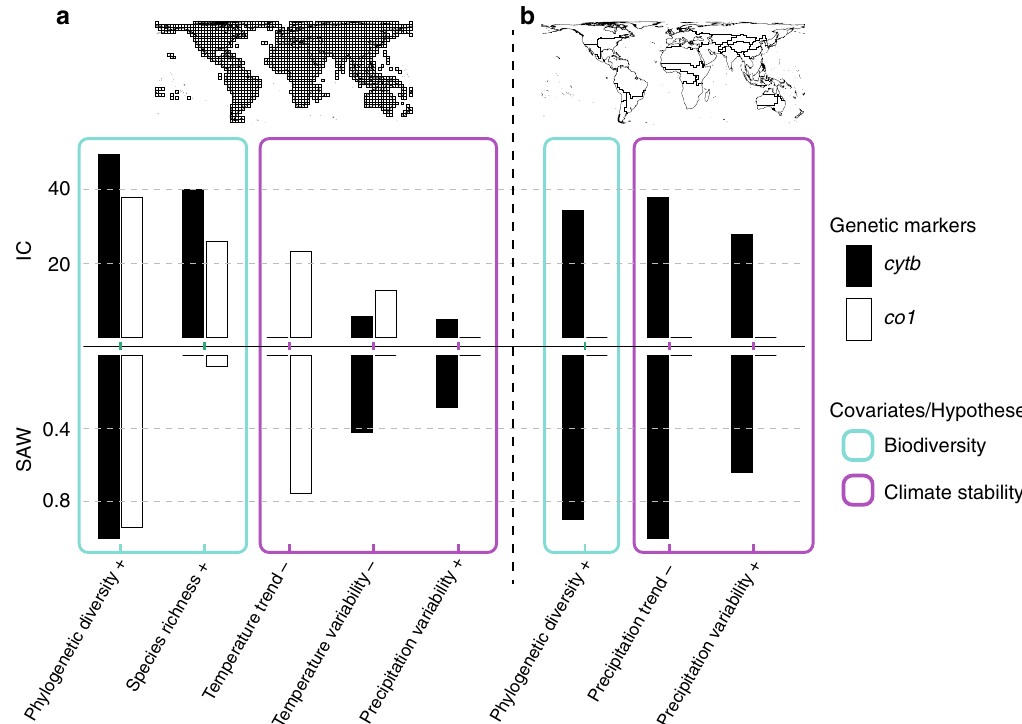
Fig. 1 Covariates of genetic diversity in terrestrial mammals at two spatial scales. Independent contribution (IC; hierarchical partitioning) and the sum of Akaike weights (SAW; multimodel inference) of biodiversity dimensions and climate variables in explaining the global distribution of genetic diversity (average number of mutations per base pair and across taxa) for cytb and co1 . Spatial scales: a grid cells ( cytb : n = 185; co1 : n = 76), and b zoogeographic regions ( cytb : n = 34; co1 : n = 30). Inferences at the grid cell scale are based only on data-rich cells (see Fig. 2 and Methods). Plus ( + ) and minus ( − ) signs after each explanatory variable indicate positive and negative signi fi cant association respectively between the explanatory variable and genetic diversity. Note that all explanatory variables for co1 at the zoogeographic scale were insigni fi cant, re fl ecting the highly unbalanced distribution of available co1 sequences across regions (Supplementary Figs. 1 –